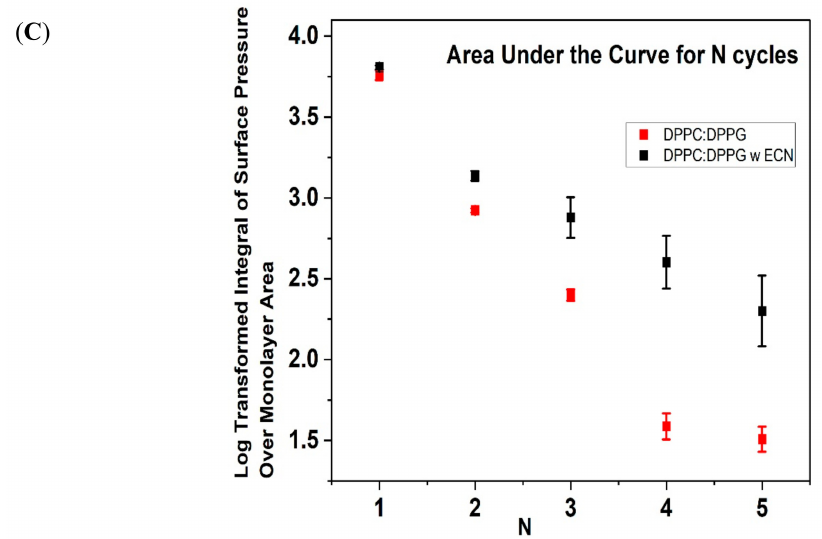
Figure 2. ( A ) Surface Pressure versus area isotherms for DPPC:DPPG (7:3) without (control, red solid line) and with 1 wt% ECN (black solid line). Here again, the samples were compressed and expanded five times to understand loss of material from the surface. An average of three samples was taken to graph the data. ( B ) The initial part of the 4th and 5th compression cycles of DPPC:DPPG monolayers with (black lines) and without (red lines) the ECN, showing the lift o ff area for each compression cycle. ( C ) Area under the curve as a function of compression / expansion cycle for DPPC:DPPG (7:3) without (control, red square) and with 1 wt.% ECN (black square). In this case, the log-transformed mean and standard deviation of three samples has been shown in the